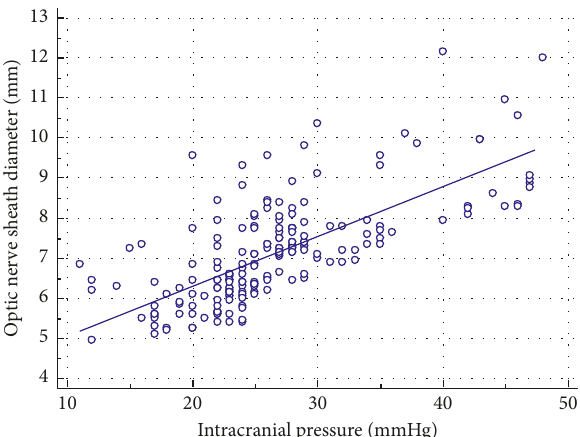
Figure 2: Mean optic nerve sheath diameter (ONSD) measure- ments plotted versus the invasive intracranial pressure (ICP) in the patients with severe traumatic brain injury.